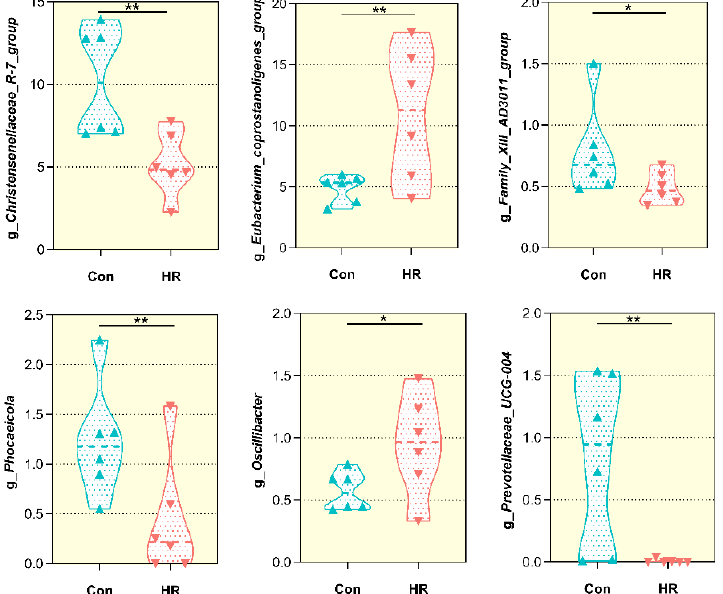
Figure 7. Relative abundance of microbial genera (percentage) in goat colons that were significantly affected by dietary treatment. Con, control diet; HR, high-rice diet. “*” means that the difference between the two groups has a significant trend (0.05 < p < 0.01), “**” means that the difference between the two groups is significant ( p <0.05).